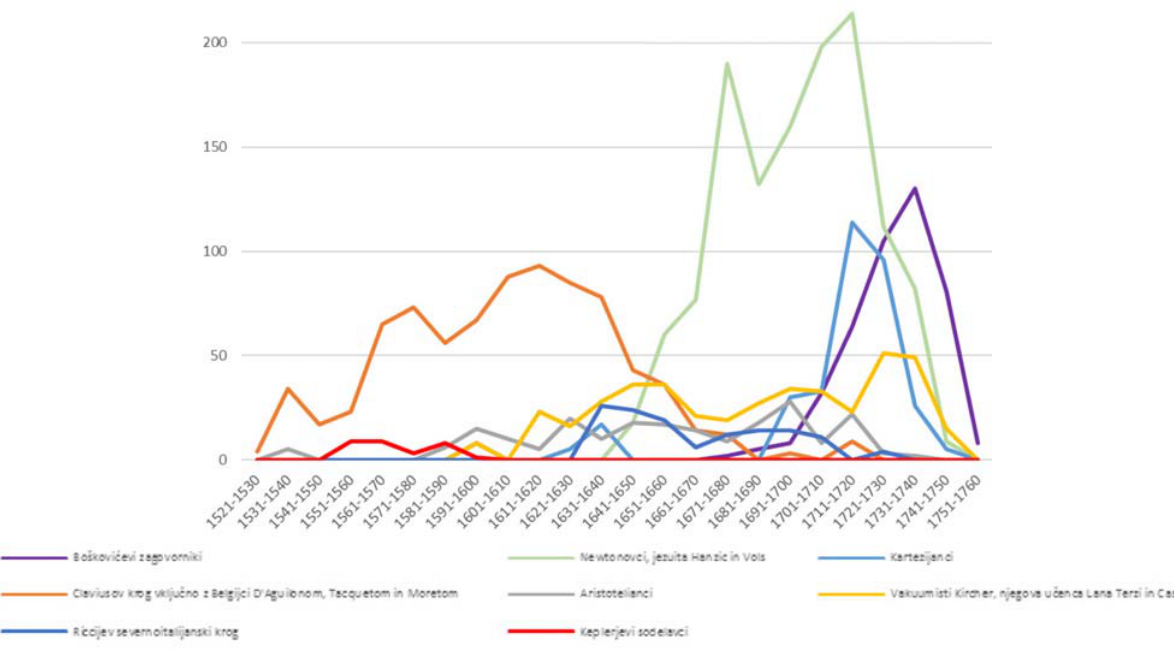
Graf 4: Spreminjanje fizikalnih idej poldrugih tiso~ jezuitskih profesorjev matematike in fizike iz avstrijske in ~e{ke province med katerimi jih je sto predavalo fiziko in matematiko tudi v Ljubljani glede na dekade njihovega rojstva.